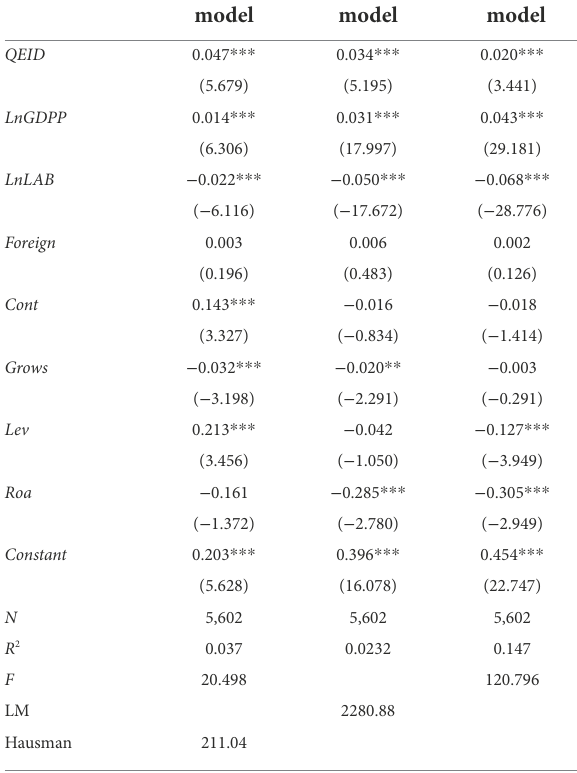
TABLE 4 Results of baseline regression.